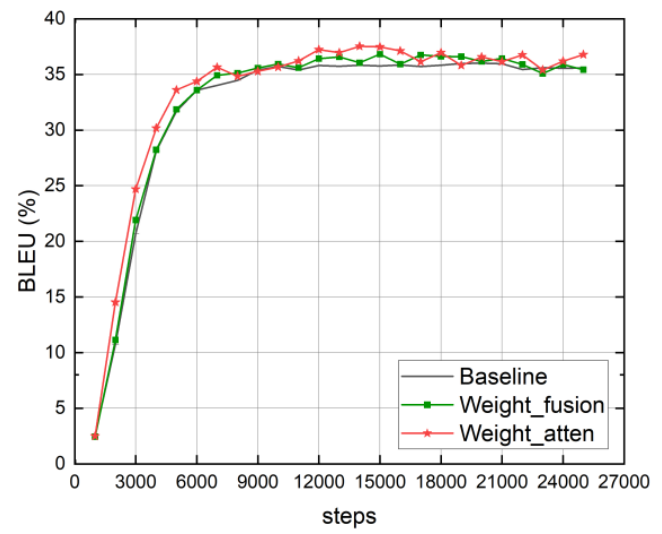
Figure 6. Comprehensive comparison of experimental results. Table 4. Comparison of translation effects.